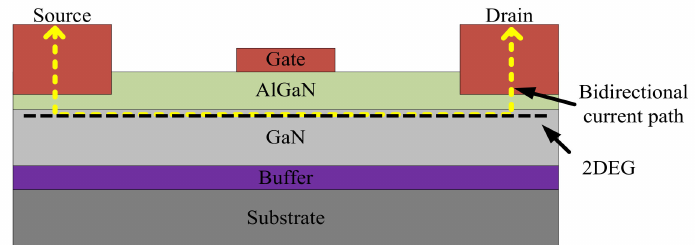
Figure 2. D-mode GaN high electron mobility transistors (HEMT).